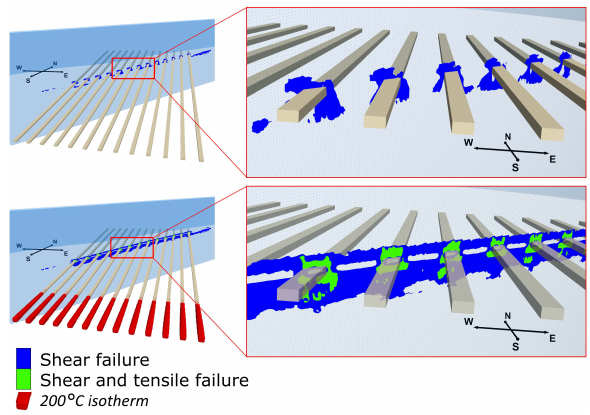
Figure 8. 3D view ( left ) and close view ( right ) of shear and tensile failure occurring at the fault plane in the isothermal ( top ) and non-isothermal ( bottom ) scenarios with 60 m pillar widths at a simulation time of 2000 days (end of UCG operation). UCG channels are represented by transparent grey shapes.